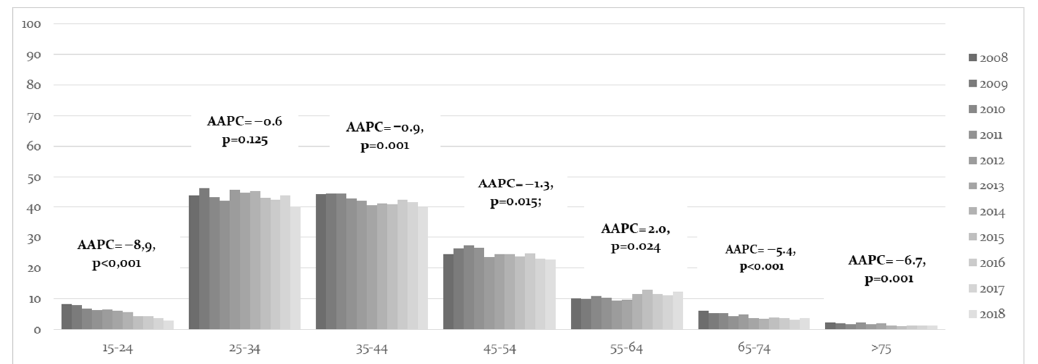
Figure 3. Average annual percent change (AAPC) of in situ cervical cancer trends understood via women’s classes of age and year of hospital admission, with related confidence intervals at 95%. During the period 2008–2017, cervical screening uptake among females aged 25–64 years old was 79.6%, with significant increases observed during the period (AAPC = 0.5%, 95% CI = 0.2, 0.7, p < 0.001). This was strongly inversely correlated with hospitalization rates due to invasive cervical cancer (r = −0.9, p < 0.001), as shown in Figure 4. Figure 4. Correlation between hospitalization rates due to invasive cervical cancer and cervical can- cer screening uptake with their respective average annual percent change (AAPC): ( a ) 2008–2018 AAPC = −2.8%, 95% CI = −3.2, −2.4, p < 0.001; ( b ) 2008–2018 AAPC = 0.5%, 95% CI = 0.2, 0.7, p < 0.001. HPV vaccination between 2009 and 2018 had a coverage of 67.2% with significant increases observed during the period (AAPC = −2.0%, 95% CI = 1.1, 2.9; p = 0.001). This trend was strongly inversely correlated with hospitalization rates due to in situ cervical cancer (r = −0.8, p = 0.005), as shown in Figure 5.